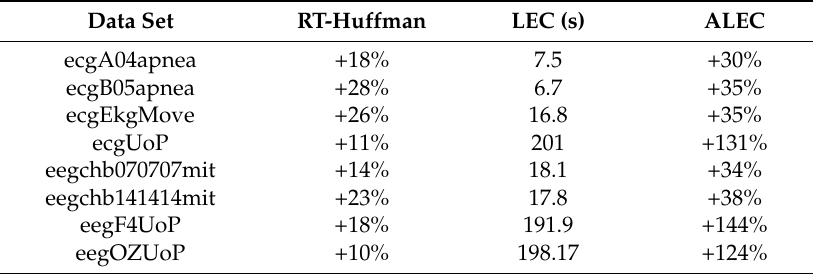
Table 1. Processing delay performance evaluation.